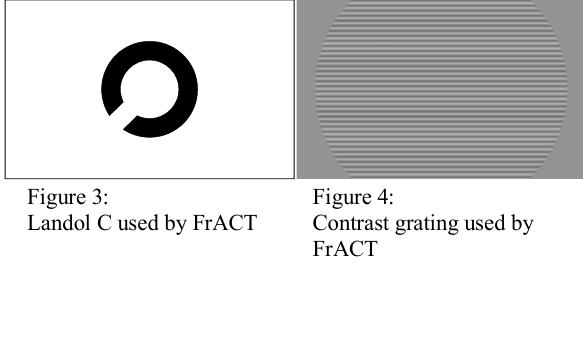
Figure 3: Landol C used by FrACT